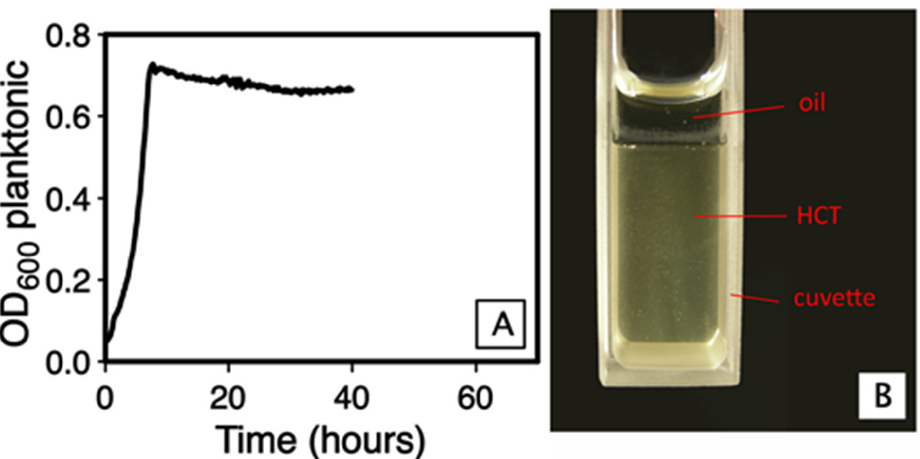
Figure 5. Growth of Bt407 in micro-aerobic condition. The culture was performed in static condition at 30°, in HCT medium and in a glass cuvette. ( A ): Time-course of the OD 600 of the planktonic population. ( B ): Picture of the cuvette after 48 h of incubation.